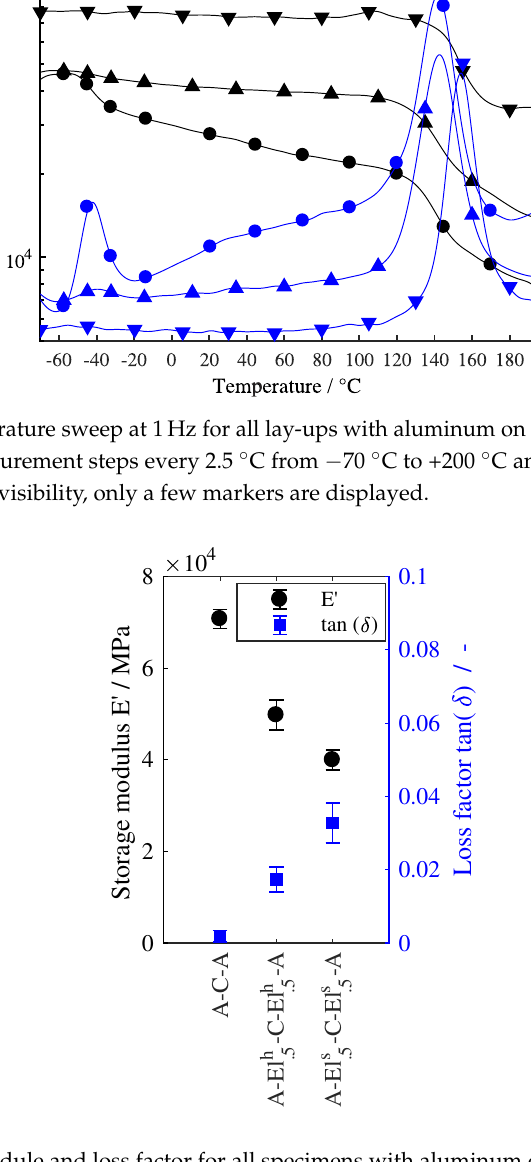
Figure 8. Storage module and loss factor for all specimens with aluminum on the outside at 20 ◦ C and 1Hz. Three specimens for each